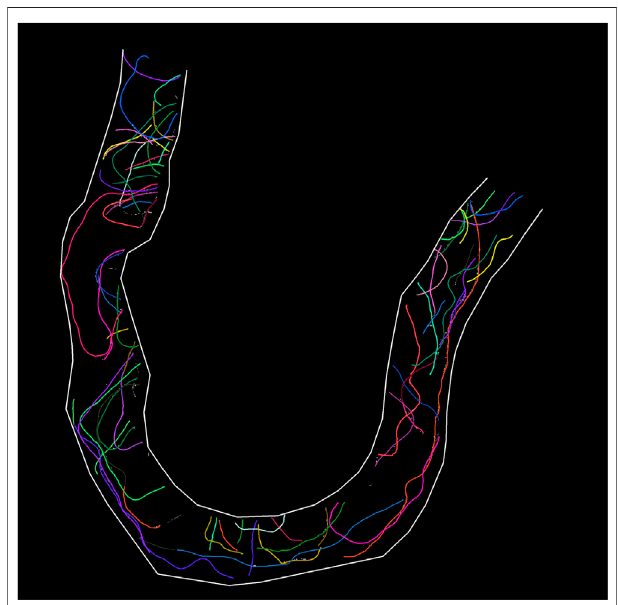
FIGURE 4 | Microtubule reconstructed fi laments occupying the 4 μ m band identi fi ed as the leading edge of the cell. MTs were reconstructed with the SIFNE software, using the cell shown in Figure 3 .